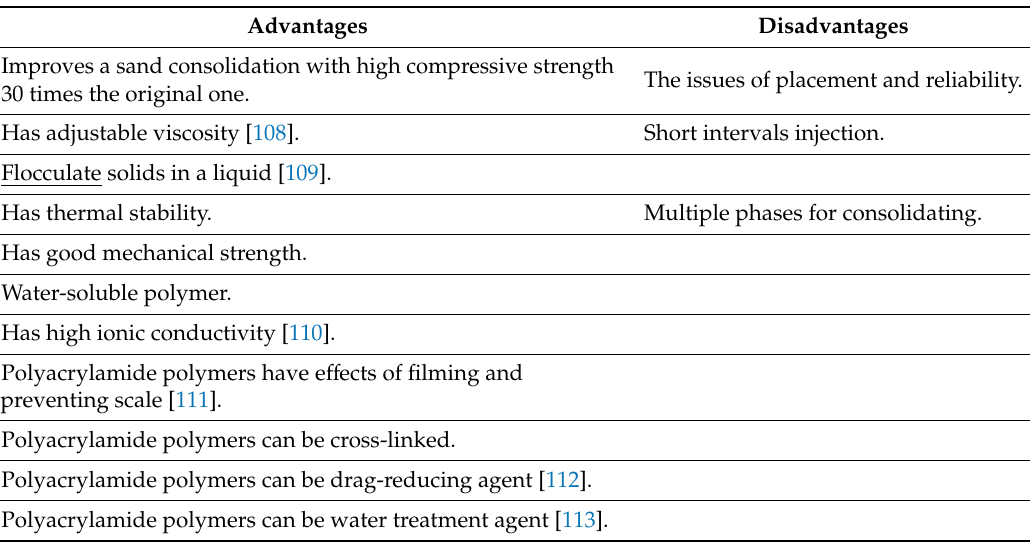
Table 22. Advantages and disadvantages of polyacrylamide polymer